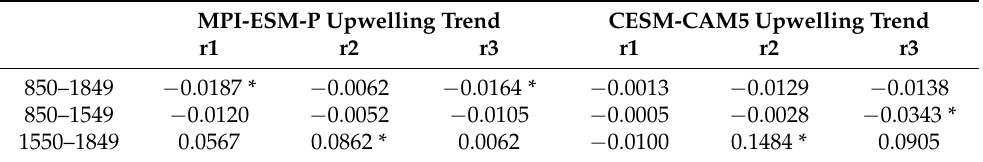
Table 3. Upwelling trends (m/day per 1000 years) calculated from the two models for different